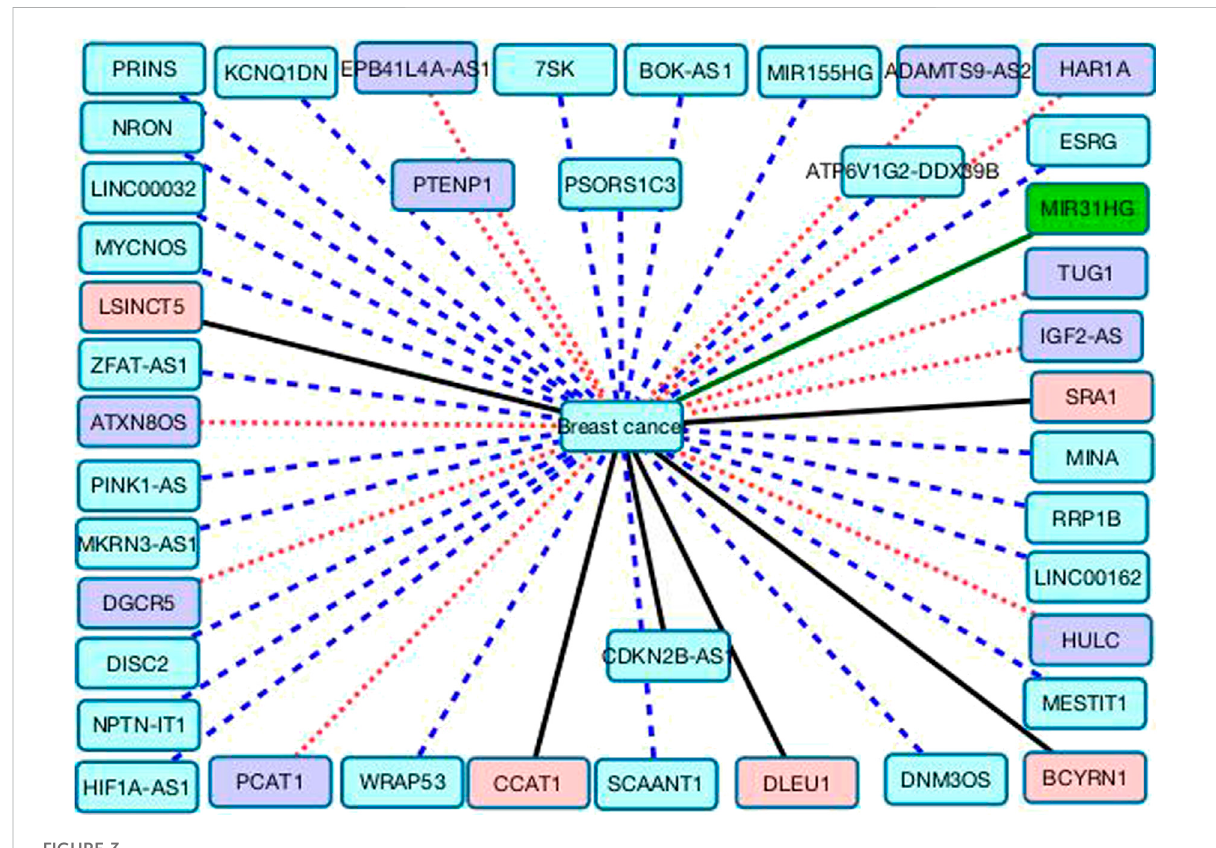
FIGURE 3 The associations between the remaining 41 lncRNAs and breast